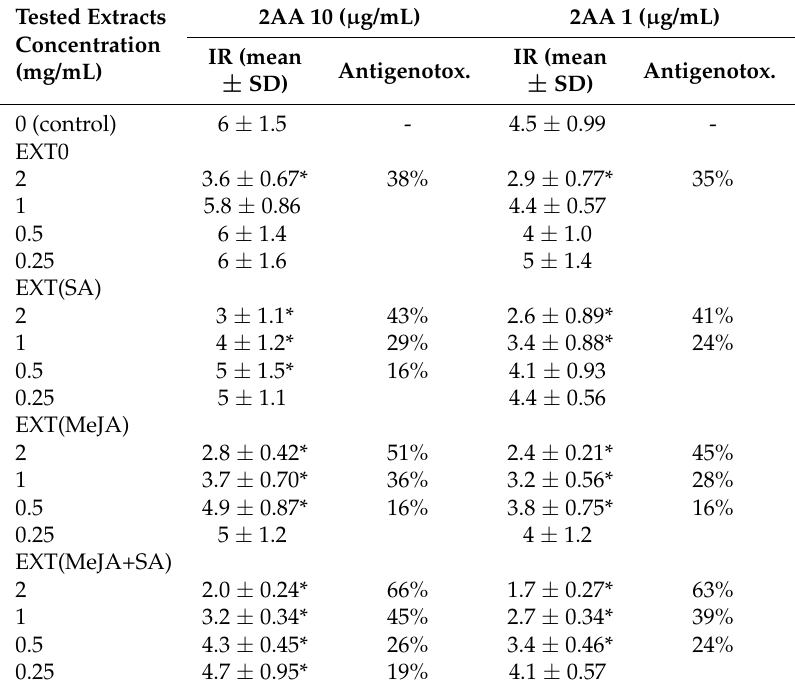
Table 5. Evaluation of antigenotoxic activity based on IR values for the control—genotoxins 2-aminoanthracene (2AA)—and the mixture of genotoxins with the tested extracts. Tested Extracts